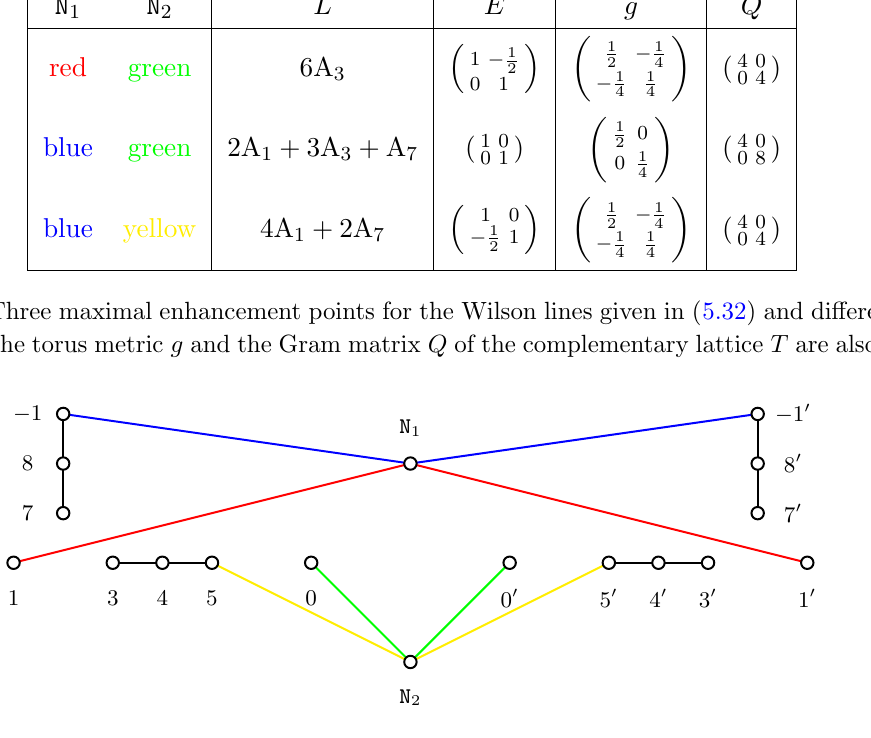
Figure 15. Dynkin diagrams for the maximal enhancements in table